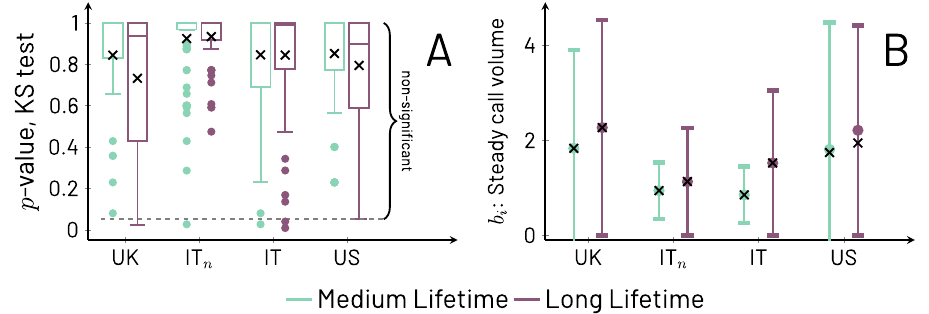
Figure 3. Panel ( A ): Box plots for all cohorts using the 1.5 interquartile range convention for p -values from Kolmogorov-Smirnov tests for egos in medium (teal) and long (purple) lifetimes in all cohorts. The per alter call averages ¯ f i ( a , ℓ) are divided into two equally-sized ranges of a , the early range � a ≤ a < ⌊ ( 1 / 2 )( ⌊ ℓ/� a ⌋ − 1 ) ⌋ � a and the late range ⌊ ( 1 / 2 )( ⌊ ℓ/� a ⌋ − 1 ) ⌋ � a ≤ a ≤ ⌊ ℓ/� a ⌋ � a − � a ). Large p -values mean that the early and late ranges of ¯ f i ( a , ℓ) are not distinguishable, and thus, show no trend with a ; small p -values mean there is a trend in a . We draw a dashed line at the 0.05 significance threshold and the averages over all egos are represented with the symbol × . As it is clear from the plot, the vast majority of egos show no trend with a . Panel ( B ): Average values of b i (ℓ) (circles) and standard error of the means (whiskers) for medium (teal) and long (purple) lifetimes for all cohorts. Superimposed to each circle and associated whisker is a symbol × that represents the value of b (ℓ) for the corresponding cohort, which matches well the averages of b i (ℓ) across cohorts and